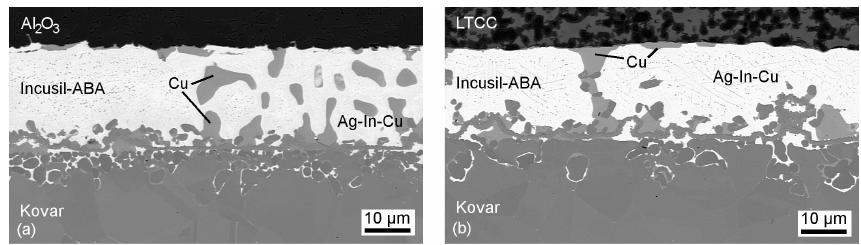
Figure 5. SEM images of Kovar–Al 2 O 3 (a) and Kovar–LTCC (b) joints brazed with Incusil-ABA at 755 ◦ C for 10min.